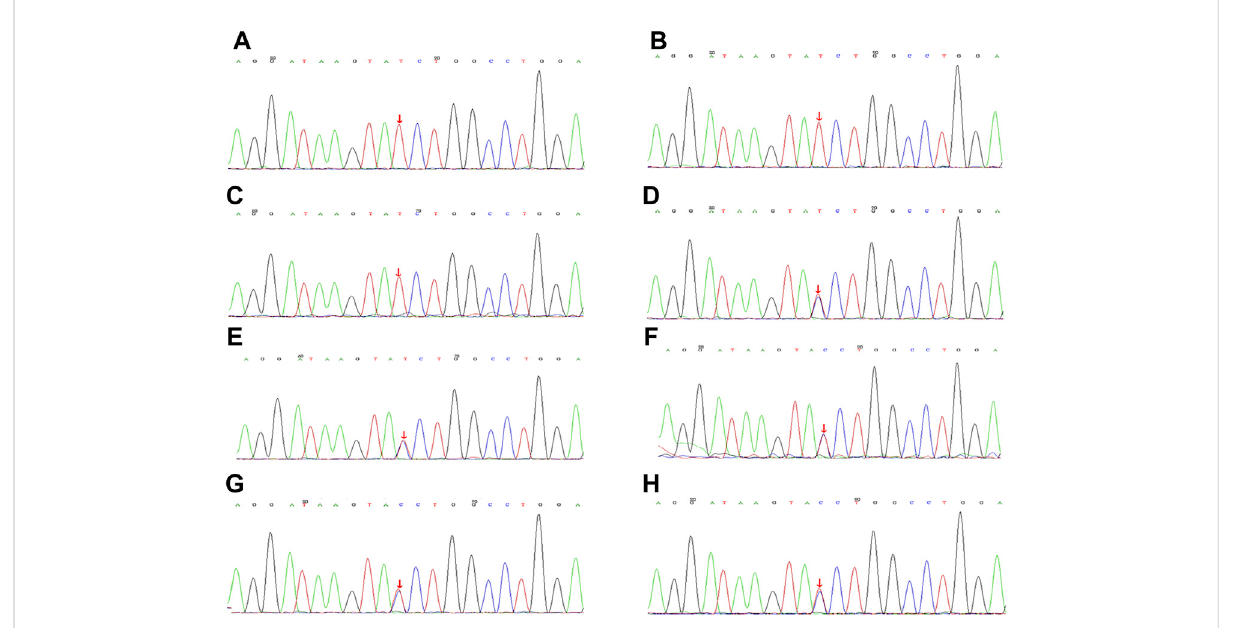
FIGURE 3 Genesequencingof family members with Aarskog-Scottsyndrome,with thevariation shown by arrows. (A) . Case 1,FGD1 genewith (C) .2015+ 1G > A semi-heterozygous variation. (B) . Case 2, FGD1 gene with (C) .2015+ 1G > A semi-heterozygous variation. (C) . The children ’ scousinFGD1 gene with (C) .2015+1G > Asemi-heterozygousvariation. (D) .FGD1genewith (C) .2015+1G > Aheterozygousvariation. (E) FGD1genewith (C) .2015+1G > A heterozygous variation. (F) . FGD1 gene with (C) .2015 + 1G > A heterozygous variation. (G) FGD1 gene with (C) .2015 + 1G > A heterozygous variation. (H) . FGD1 gene with (C) .2015 + 1G > A heterozygous variation.